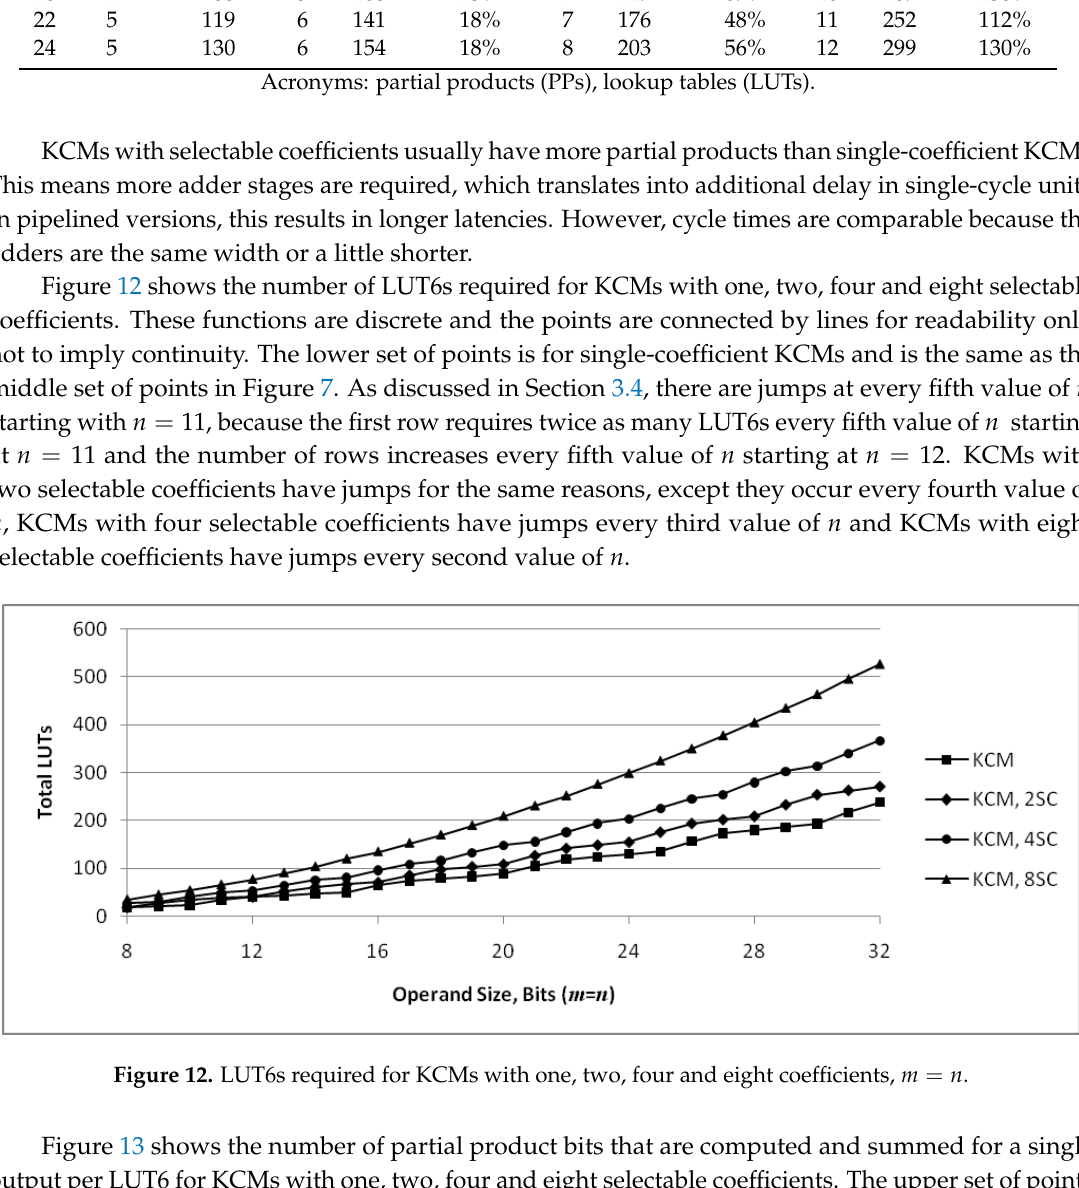
Acronyms: partial products (PPs), lookup tables (LUTs).